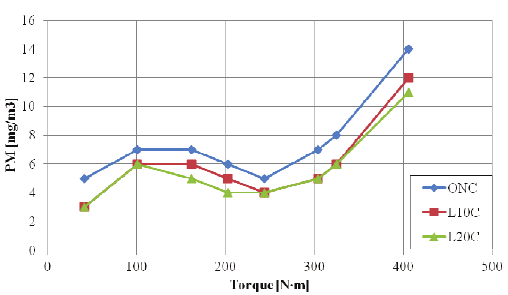
Fig. 13. PM for injection timing C and n = 2000